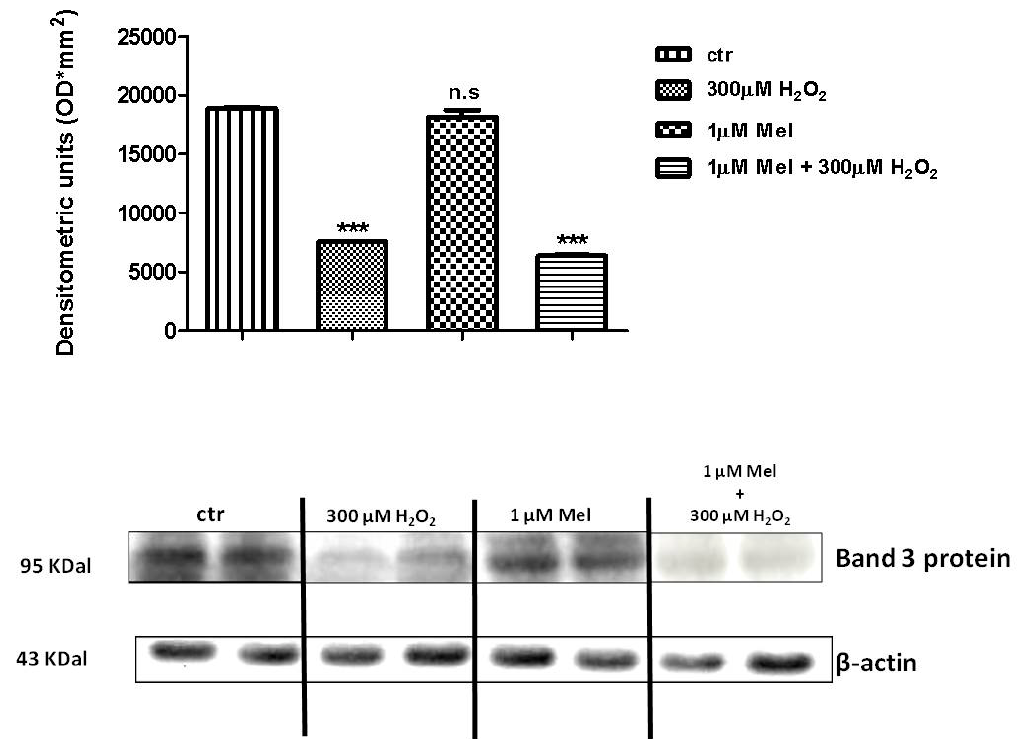
Figure 8. Expression levels of Band 3 protein measured in untreated erythrocytes (ctr), or in 300 µ M H 2 O 2 - or in 1 µ M Mel or in 1 µ M Mel + 300 µ M H 2 O 2 -treated erythrocytes, detected by Western blot analysis. *** p < 0.001 vs. ctr; n.s. not significant vs. ctr, as determined by one way ANOVA followed by Bonferroni’s post hoc test (N = 5).